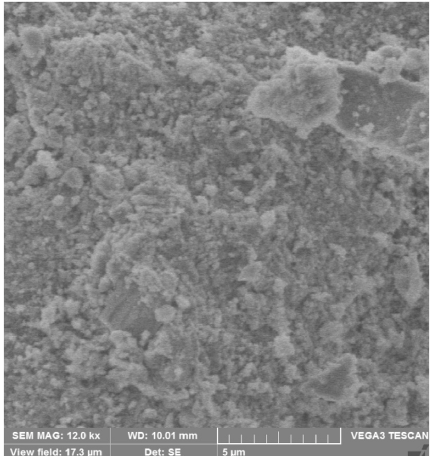
Figure 11: Microstructure of control SCC.